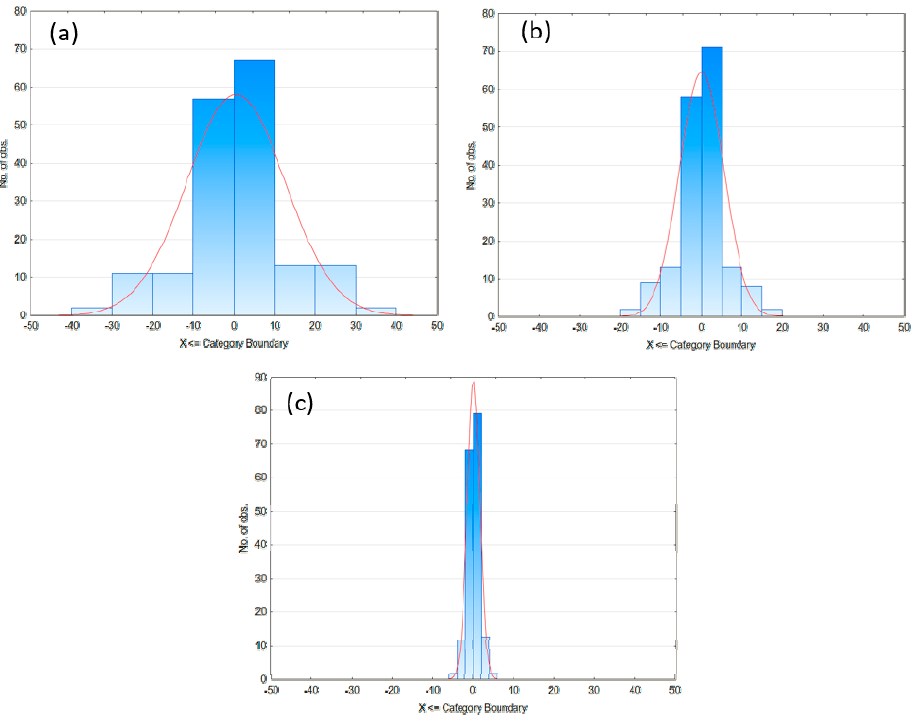
Figure 9. Residual distribution of Zener ( a ), Lethersich/Jeffreys ( b ), and Burgers model ( c ). Table 11. Calculated Burgers parameter for Elastollan 1180A, according to Equations